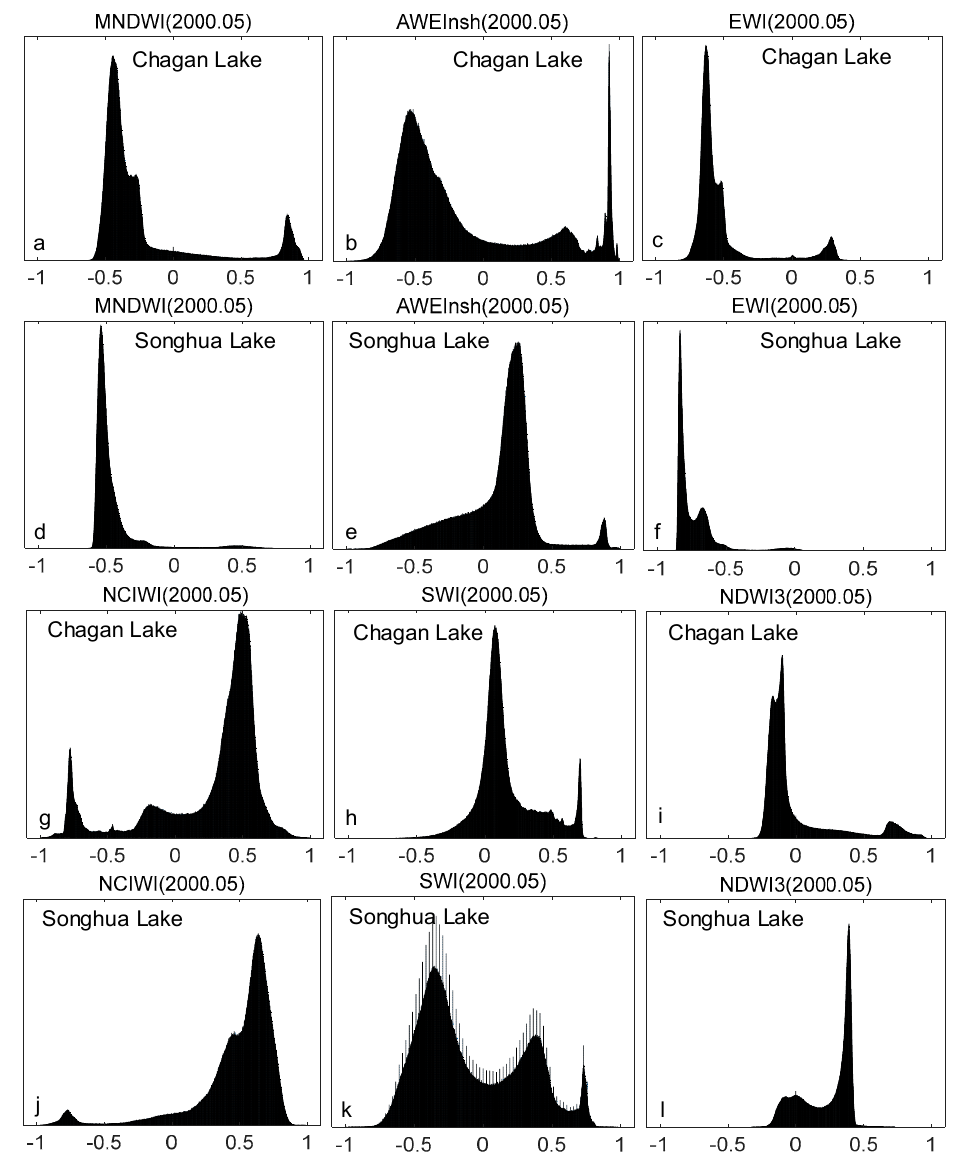
Figure 4. Gray histogram of MNDWI ( a,d ), AWEInsh ( b,e ), EWI ( c,f ), NCIWI ( g,j ), SWI ( h,k ) and NDWI3 ( i,l ) images in May 2000 of the two study regions.